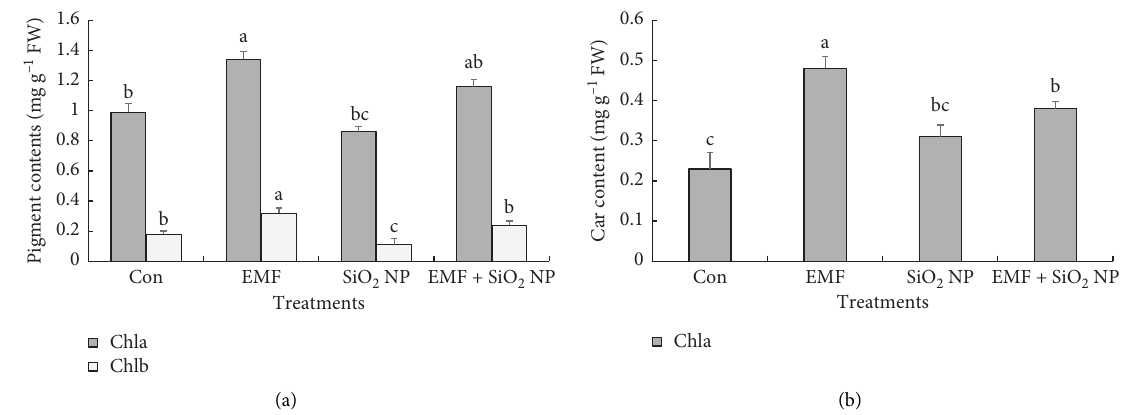
Figure 2: Effect of EMF and SiO 2 NP treatments on chlorophyll a and b (Chl) (a) and carotenoid (Car); (b) contents of A. gilanica plants. Bars indicate means ± SE ( n � 5) in each group. Different letters indicate significant differences at P ≤ 0 . 05.